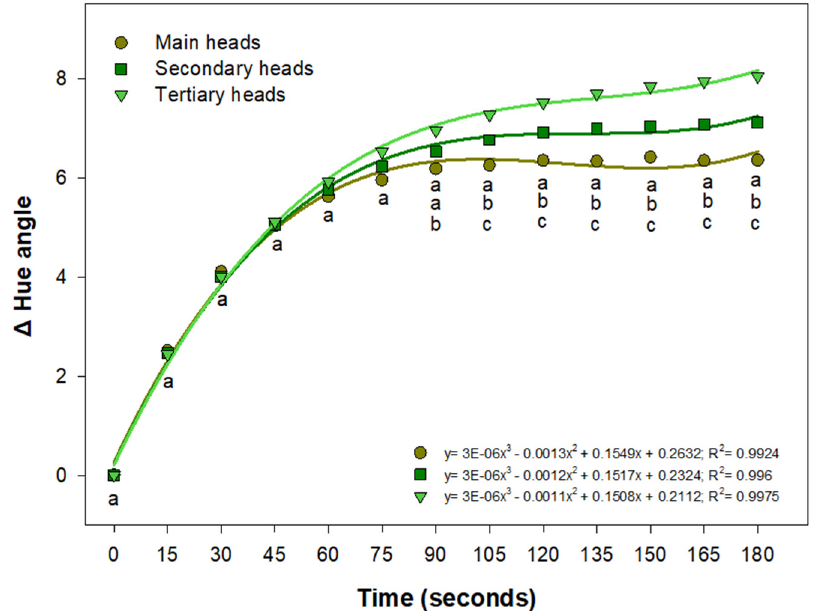
Figure 2. Effect of colour change ( ∆ Hue angle) of fresh-cut artichoke heads every 15 s for 3 min. Different letters show statistical differences ( t Student test, p < 0.05) among artichoke head orders for ‘Lorca’ cultivar.